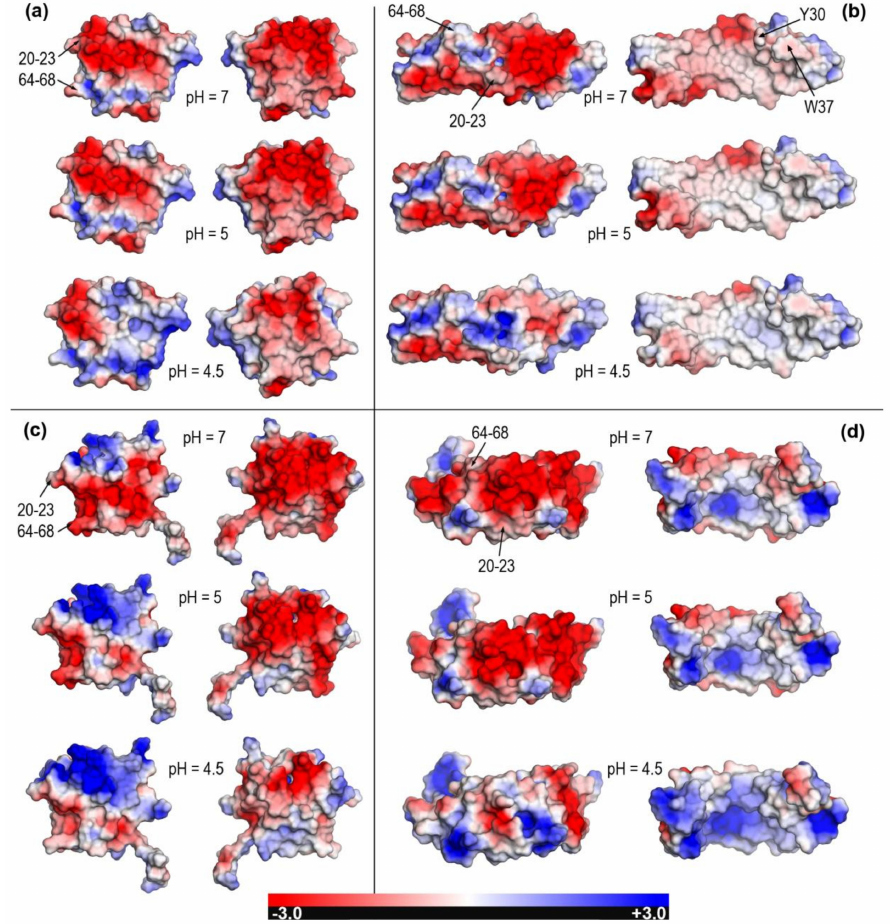
Figure 4. Poisson-Boltzmann electrostatic potential mapped onto molecular surfaces of saposins A and C at pH 7, 5, and 4.5. ( a ) Closed form of saposin A (chain A in 4UEX). ( b ) Open form of saposin A (4DDJ). Surfaces of Y30 and W37 residues with solvent-exposed protruding side chains are indicated only in the first row. ( c ) Closed form of saposin C (conformation 1 in 1M12). ( d ) Open form of saposin C (conformation 1 in 1SN6). Right views in each panel are obtained from left views upon 180 o rotation around a vertical axis. Segments involved in the closed → open transformation (Figure 2) are labeled only in left images of first